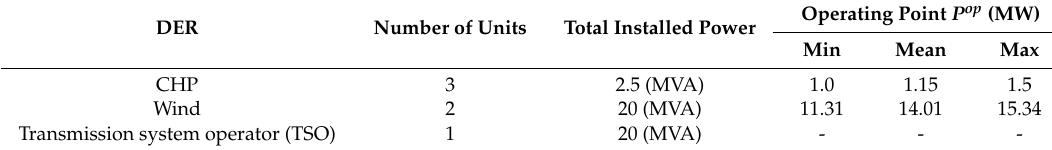
Table 3. General characteristics and operating point for distributed energy resources (DER).